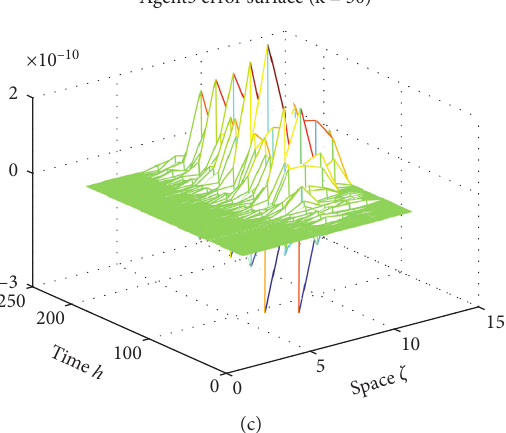
Figure 5: Error surface between each of the three agents in nonlinear parabolic partial MASs. (a) Agent1 error surface ( k � 30). (b) Agent2 error surface ( k � 30). (c) Agent2 error surface ( k � 30).